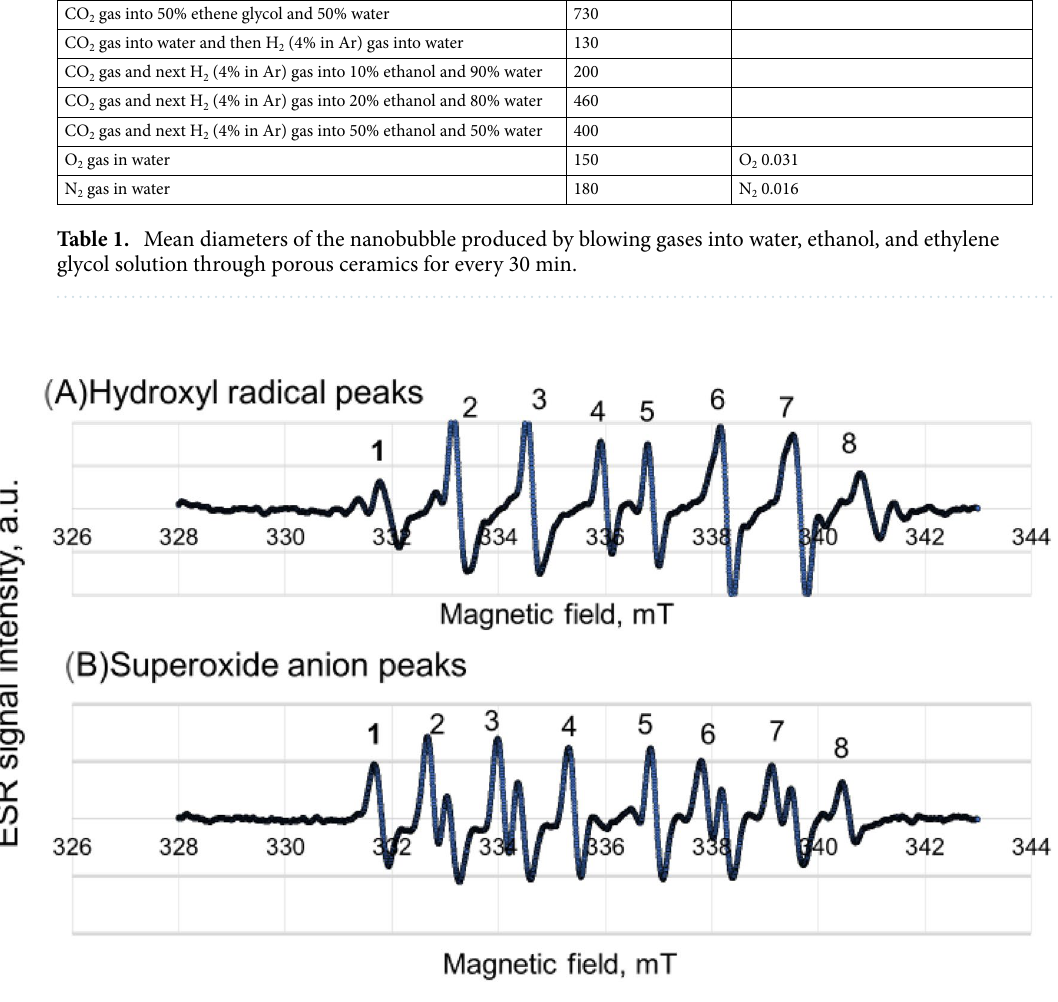
Figure 1. Comparison between hydroxyl radical ( A ) and superoxide anion ( B )